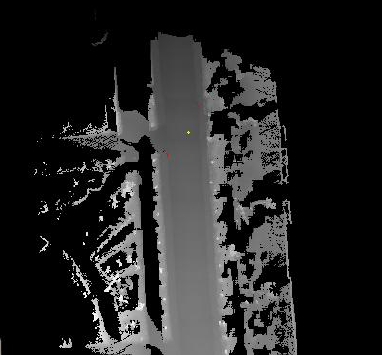
Figure 2. The local DEM in static environment.